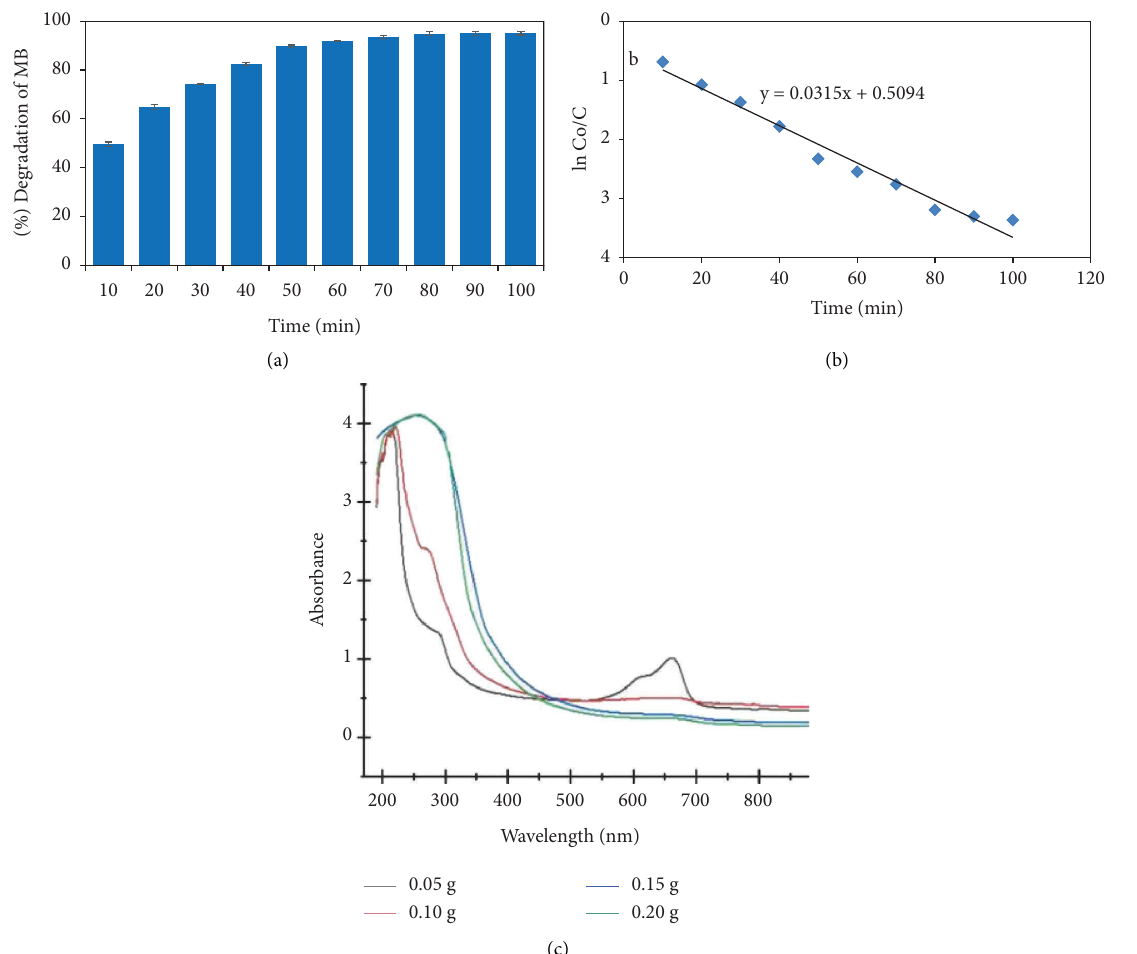
Figure 6: Photodegradation of methylene blue with the passage of time (a), kinetic rate constant (b), and UV-Vis spectrum of degraded MB dye (c).